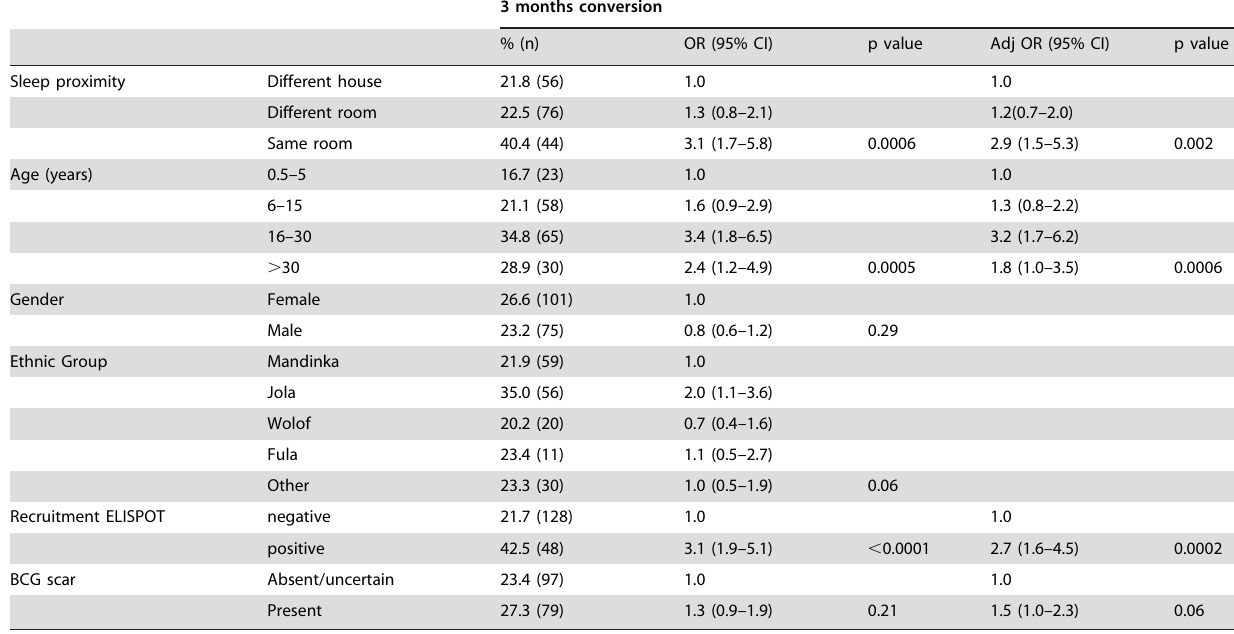
6 or CFP-10 and the T cell response may vary with evolution of an Table 2. Evaluation of possible factors associated with tuberculin test conversion at 3 months in 704 TB case contacts. .. ... .... ... ... .... ... ... .... ... ... .... ... ... .... ... ... .... ... ... .... ... ... .... ... ... .... ... ... .... ... ... .... ... ... .... ... ... .... ... ... .... ... ... . 3 months conversion